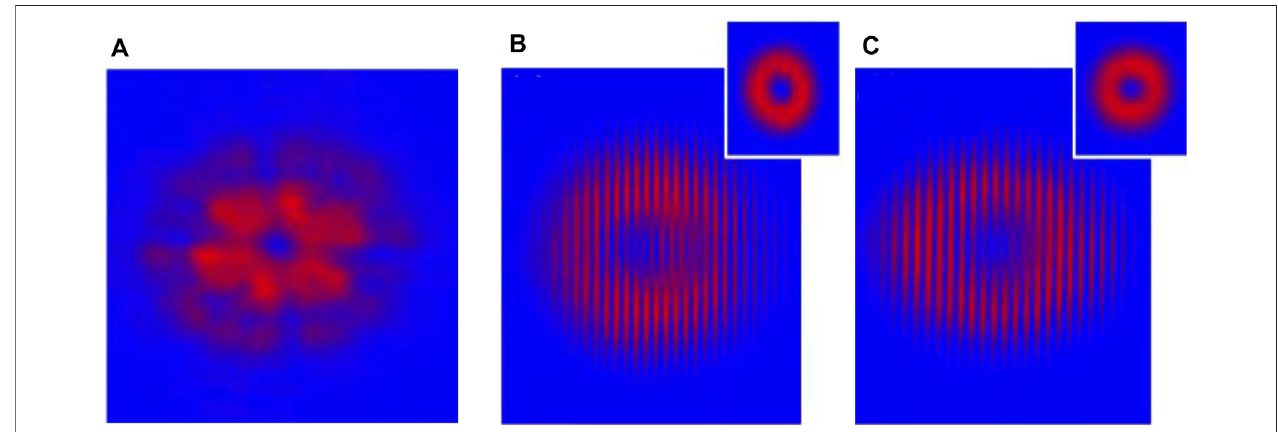
FIGURE 7 | (A) Spatial pro fi le of the fundamental beam; (B) spatial pro fi le (top right) and the interference fringes of the 1,108 nm Stokes output; (C) spatial pro fi le (top right) and the interference fringes of the 1,173 nm Stokes output [123].